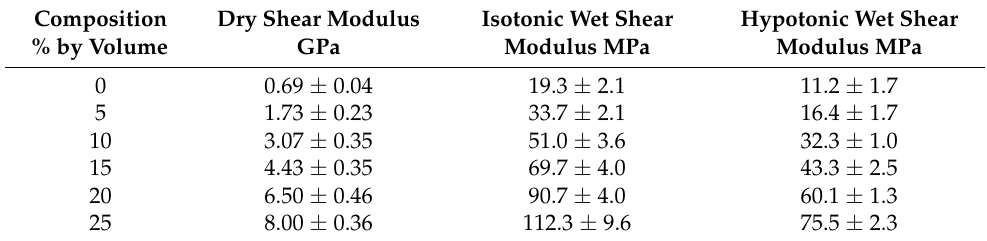
Table 1. Shear Moduli of dry and swollen in Iso- and Hypo-tonic physiological solutions pHEMA/nanosilica hybrid